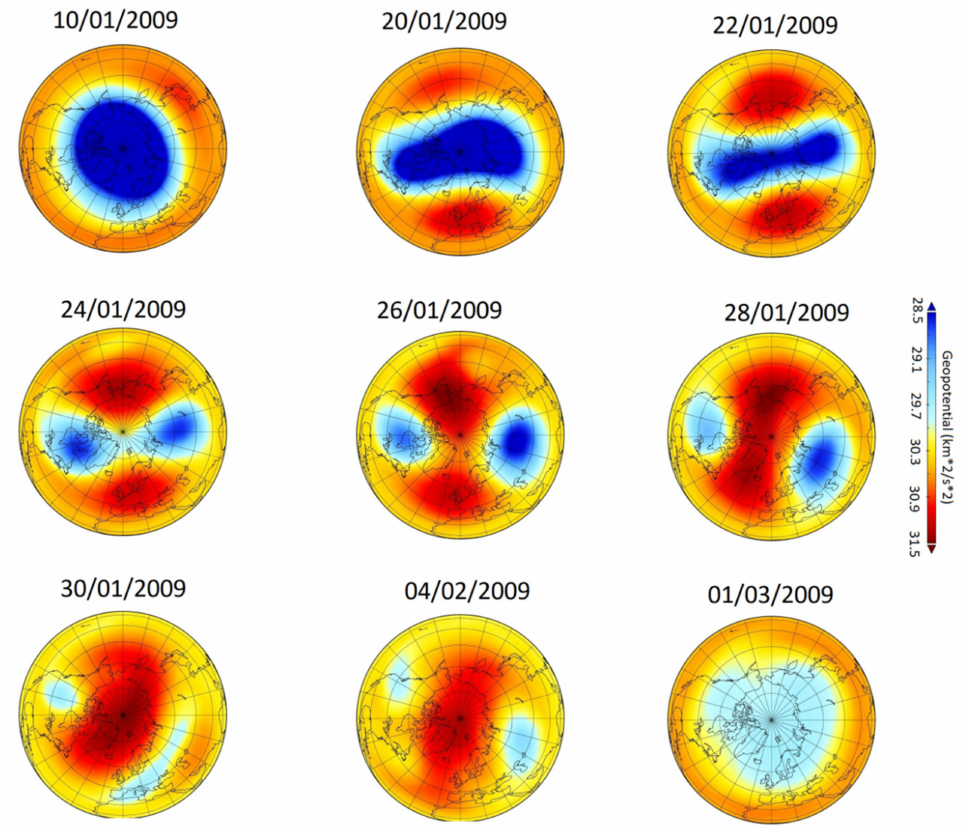
Figure 8. Geopotential heights at 10 hPa during SSW in 2009 in the